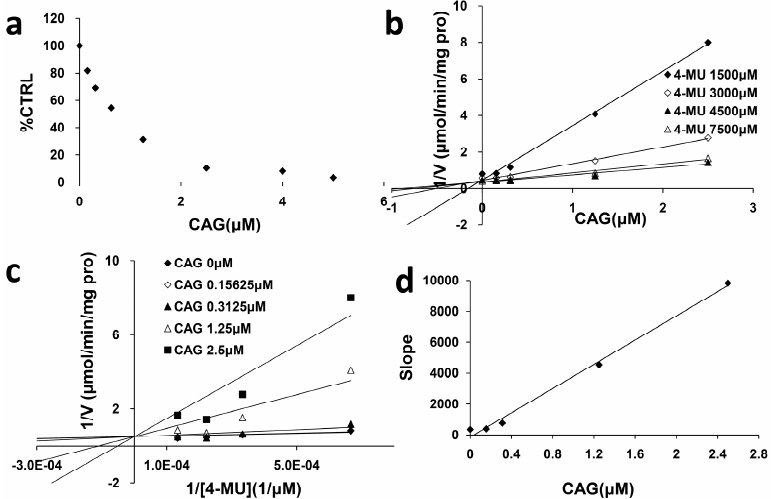
Figure 3. Determination of inhibition type and parameters ( Ki ) of CAG towards UGT1A8. ( a ) Dose-dependent inhibition of CAG towards UGT1A8; ( b ) Dixon plot of inhibition of CAG towards UGT1A8; ( c ) Lineweaver-Burk plot of inhibition of CAG towards UGT1A8; ( d ) Second plot of inhibition of CAG towards UGT1A8. The data point represents the mean value of duplicate experiments.